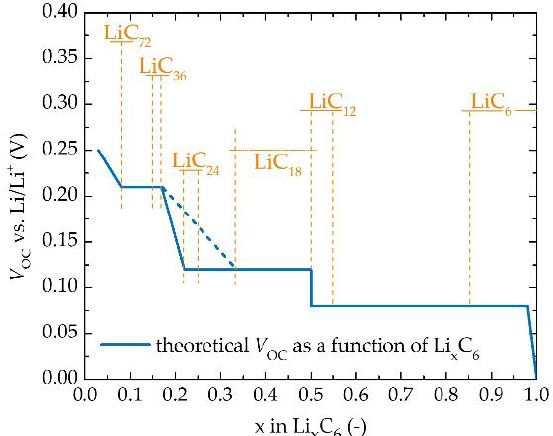
Figure 5. ( a ) Voltage profile of GITT discharging of NCR18650B battery, and ( b ) close-up view of one GITT pulse with highlighted parameters.